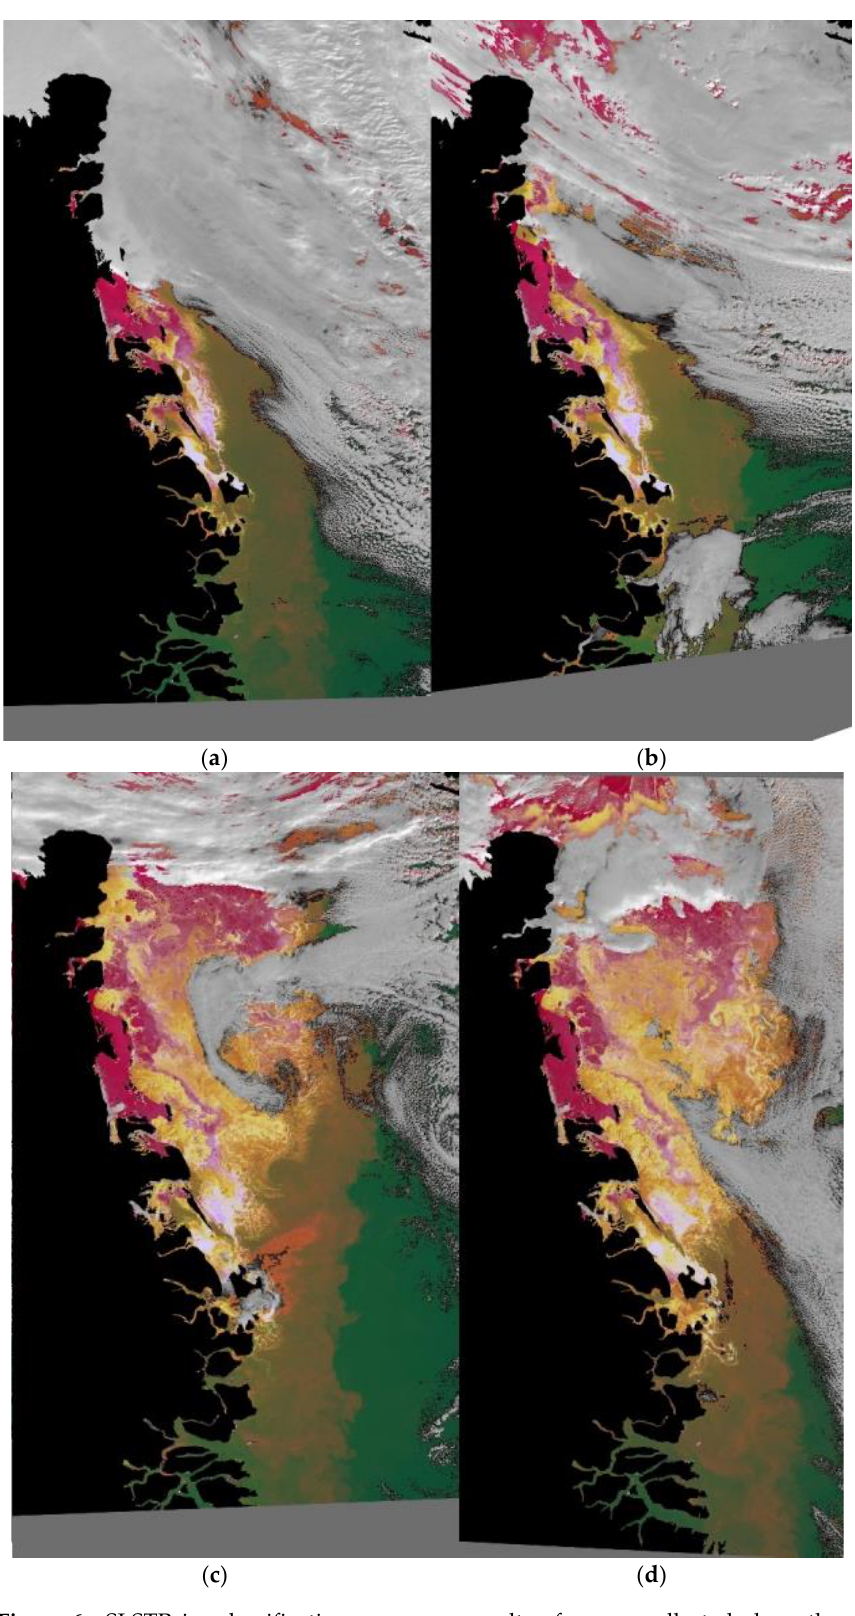
Figure 6. SLSTR ice classification sequence; results of scenes collected along the east coast of Greenland between 70° N and 82° N at 23 ( a ), 24 ( b ), 27 ( c ), and 30 ( d ) September 2018.